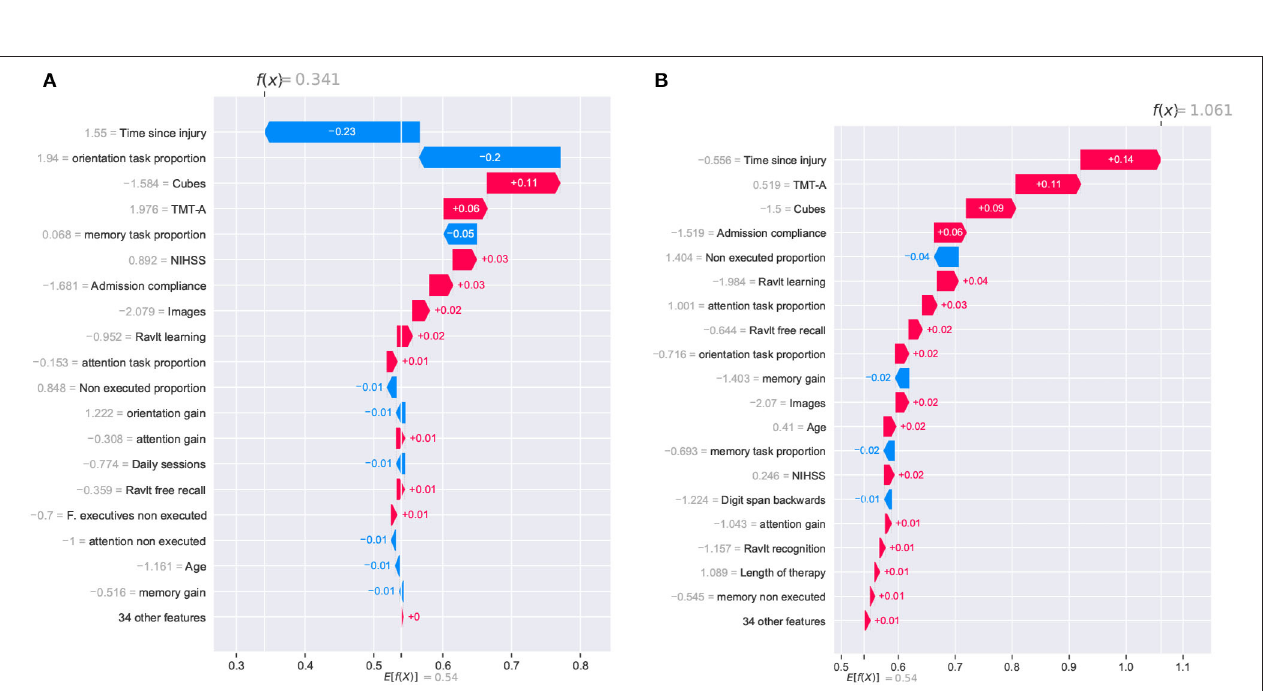
FIGURE 8 | SHAP waterfall plots for explanations of individual predictions. Illustrative cases of two patients with the highest global improvement scores. Positive feature effects are represented in red and negative effects in blue. The plot should be read from E [ f ( x )], the expected value of the model output, toward f ( x ), the model output. Positive outcomes in the x-axis (in log-odds units) are probabilities above 0.5 of classifying a patient as a cognitive improvement case (class “1”). (A) Patient_123 and (B) Patient_133.